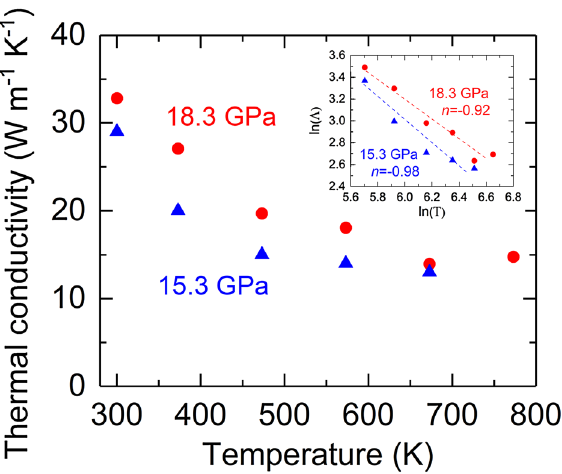
Figure 2. Temperature dependence of the thermal conductivity of NaCl at high pressures. The inset shows the lnΛ-ln T plot, where linear interpolation of each set of data derives the exponent of the power law �( T ) = α� 0 T n , where n = −0.98 and −0.92 for the thermal conductivity at 15.3 and 18.3 GPa, respectively. The experimental uncertainties are typically ~